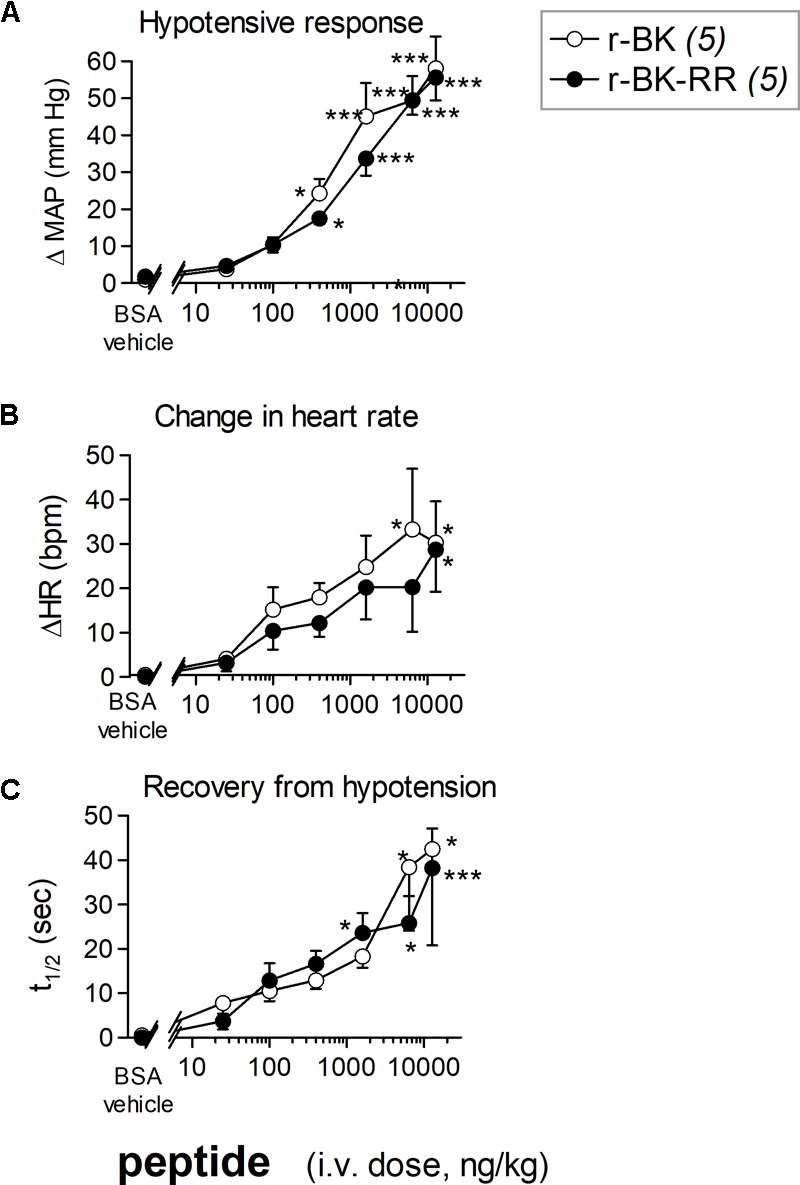
Hemodynamic responses in anesthetized rats treated with increasing doses of a peptide of the r-BK series. (A) Maximal hypotensive responses to i.v. bolus injections of increasing doses of r-BK and r-BK-RR. ANOVA indicated that, for each group of rats, the effects of the doses differed (P < 10-4 for each peptide). Dunnett’s test for difference from the effect of the saline-BSA vehicle: ∗P < 0.05, ∗∗∗P < 0.001. (B) Change in heart rate at the moment of maximal hypotensive effect. The ΔHR values related to the different doses of r-BK and r-BK-R-R were heterogenous (ANOVA, P < 0.05 in each case; Dunnett’s test vs. vehicle represented as in A). (C) Time to recover one half of the hypotensive effect after reaching the maximal value after bolus injection of each dose of peptides. ANOVA indicated that, for each group of rats, the effects of the doses differed (ANOVA, P < 0.05 and 0.001, respectively; Dunnett’s test vs. vehicle represented as in A).